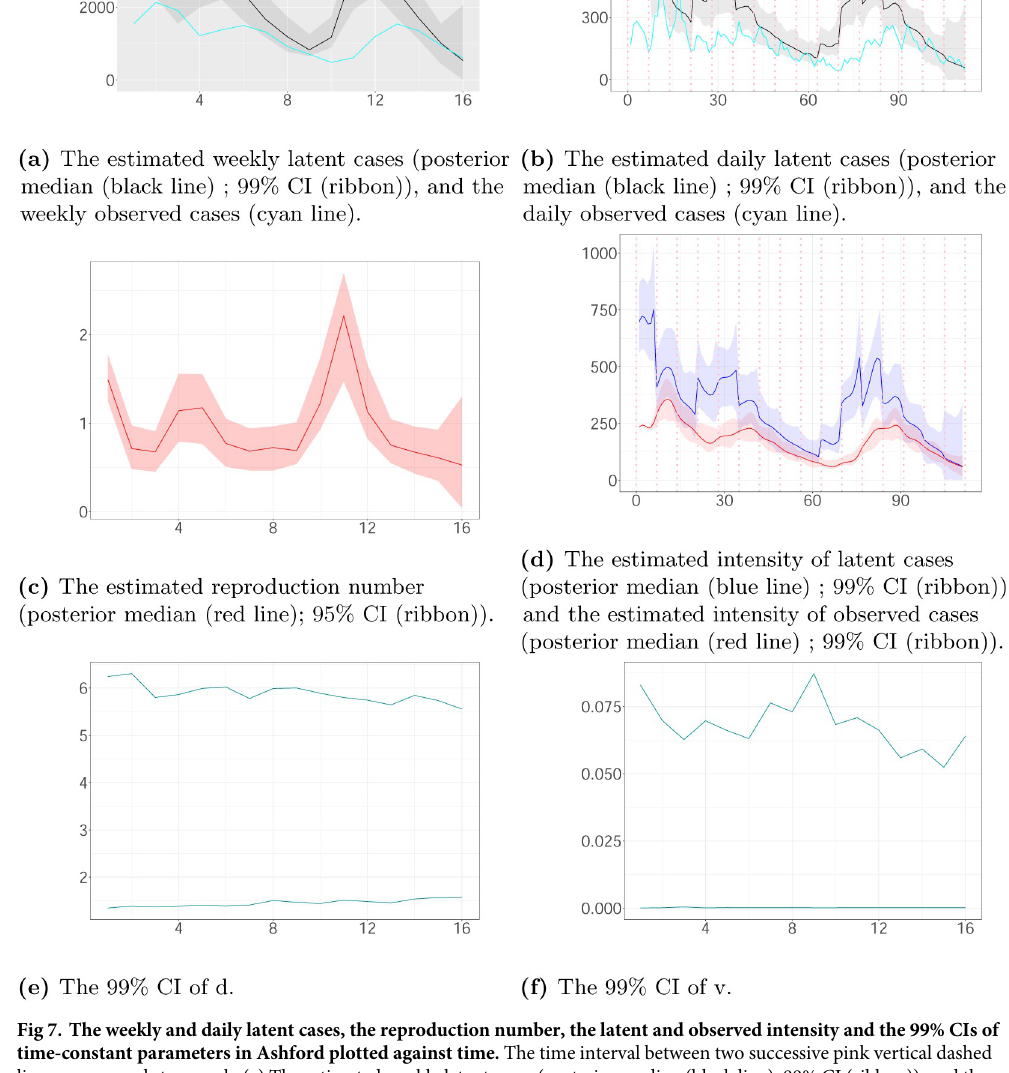
To assess the performance of our algorithm, we compute the mean absolute percentage error (MAPE) of the computed estimate of weekly observed cases (see Algorithm 6):